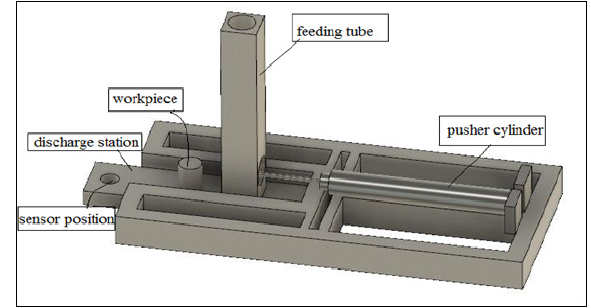
Fig. 4. The feeding unit .